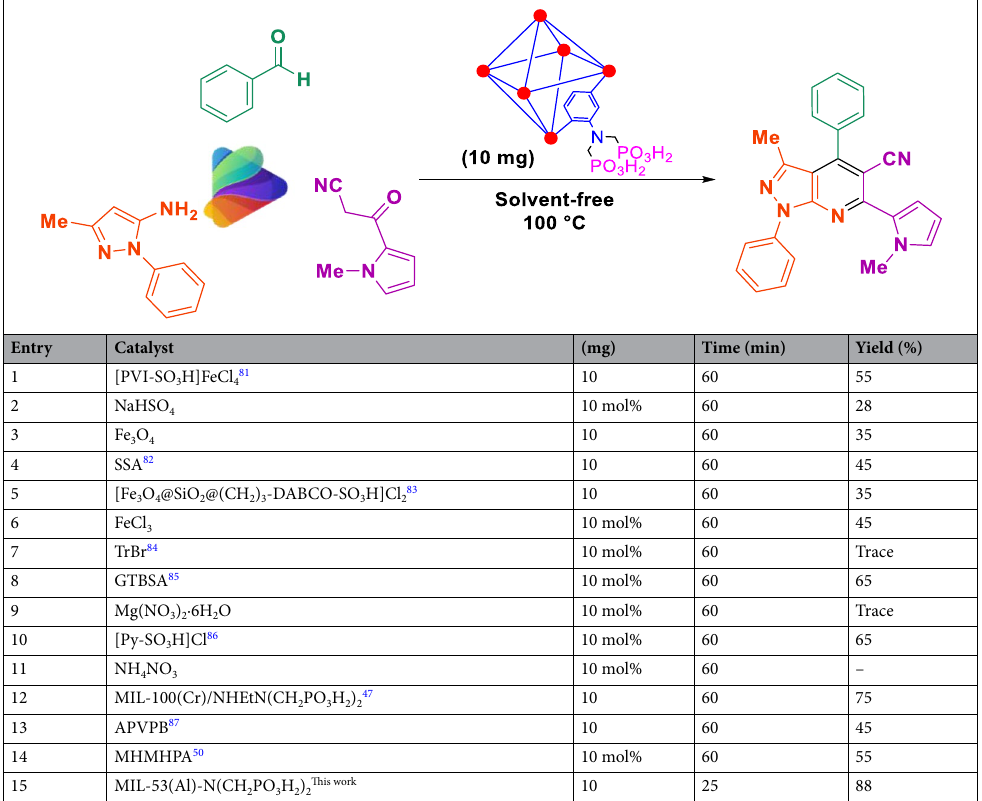
Table 4. Evaluation of various catalyst for the synthesis of novel ( N -methyl-pyrrol)-pyrazolo[3,4- b ]pyridines in comparison with MIL-53(Al)-N(CH